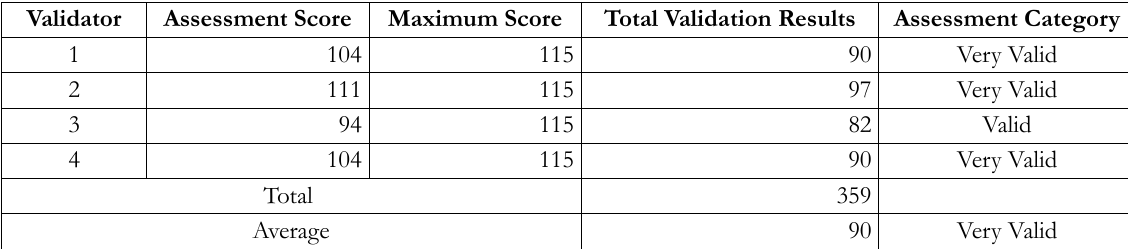
Table 4. Recapitulation of validation results for the development of network-based online learning design